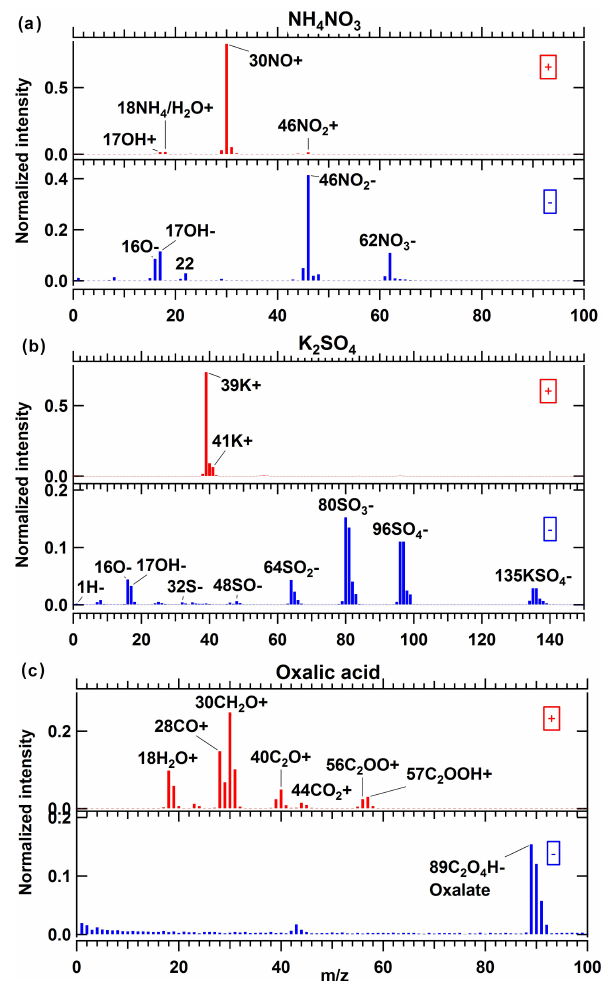
Figure 3. Average mass spectra for pure compound aerosol parti- cles: (a) NH 4 NO 3 ( d va = 1160nm), 497 single spectra averaged; (b) K 2 SO 4 ( d va = 1465nm), 300 single spectra averaged; and (c) oxalic acid particles ( d va = 1081nm ), 736 single spectra av-